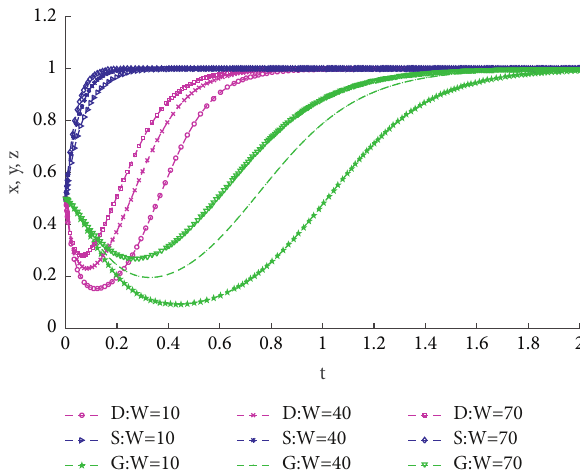
Figure 5: The platform penalizes the service provider for the evolutionary result of the change.